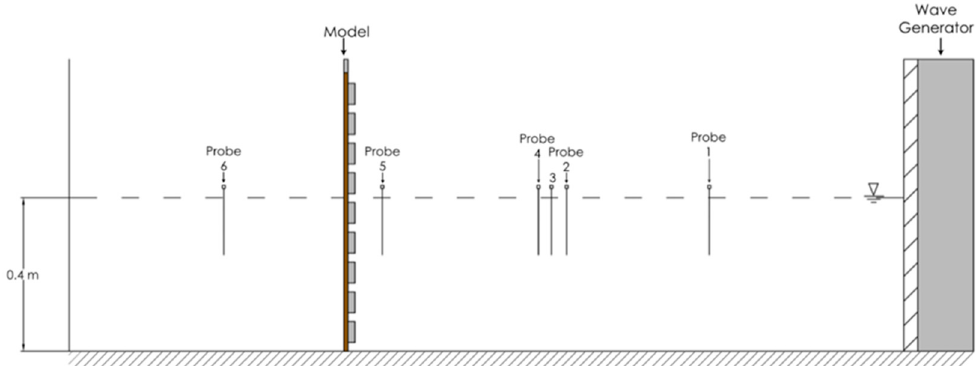
Figure 2. Side view of the wave flume showing the locations of the wave probes.